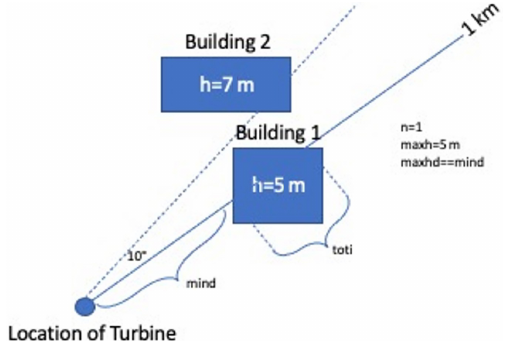
Figure 7. An example of featurization in which only one building intersects the 1km ray at the present angle, so n = 1 and max hd = min d , while max h = 5 (the height of the intersecting building), min d is the distance to the leeward face, and tot i is the total length of the intersection in